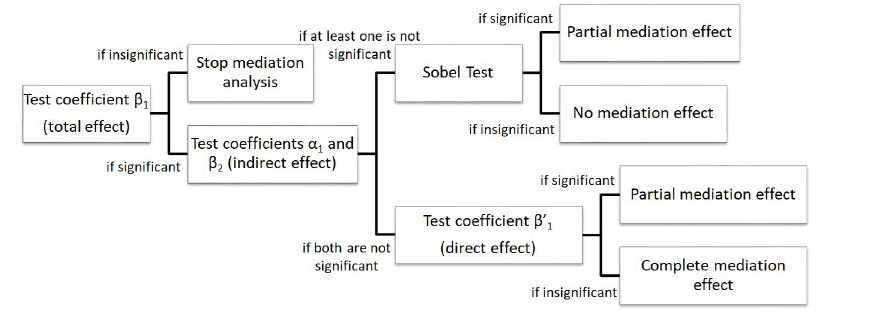
Fig 2. Mediating effects test procedure (Source: Wu et al.